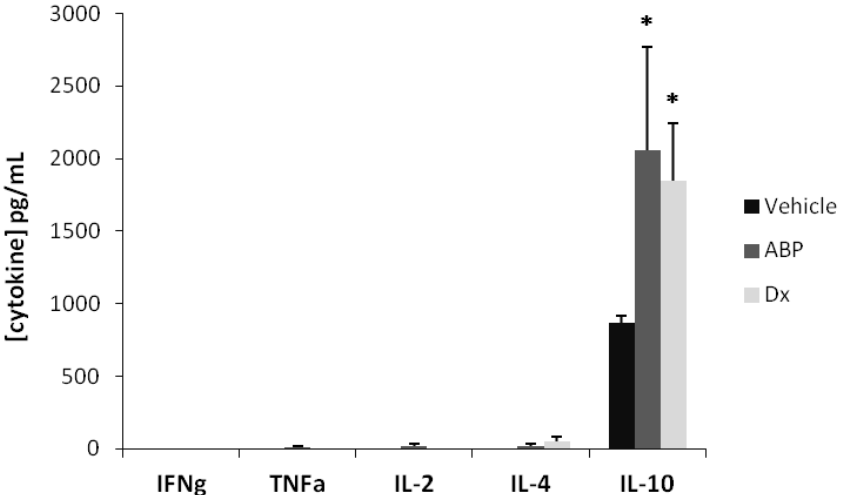
Figure 4. Cytokine concentrations (pg/mL) in serum. CBA analysis was achieved 24 h after EIU induction. Dendrimer ABP was administered at 2 µg/eye. Dx is for dexamethasone at 20 µg/eye. Histograms represent the mean of concentration measurements in the serum of each animal + SEM. * p < 0.05 vs. saline